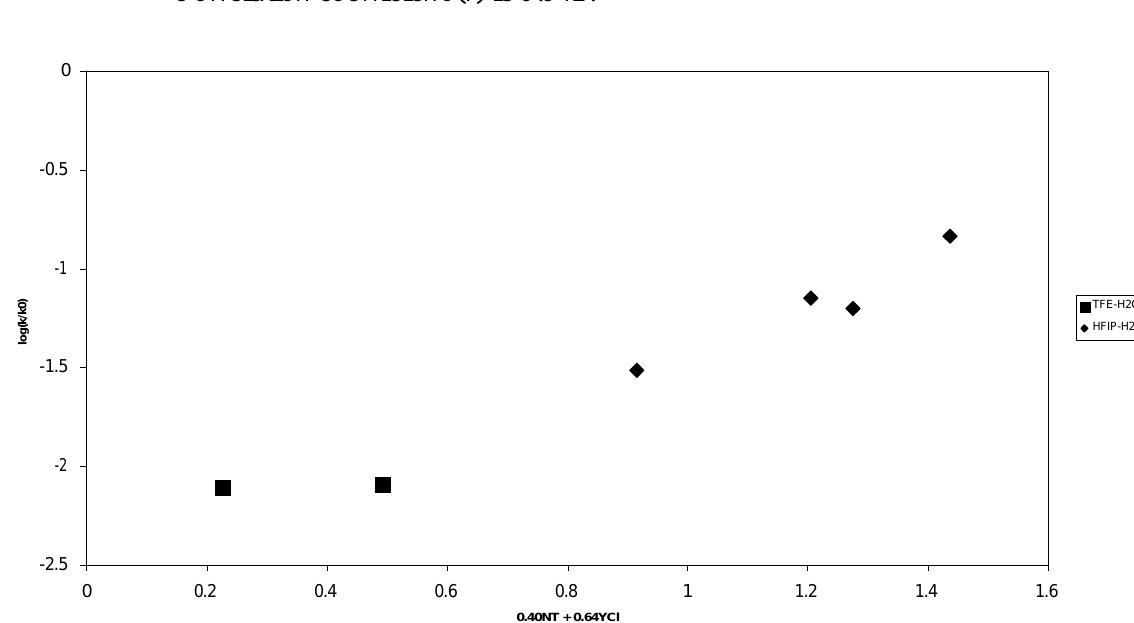
) vs. (0.40 N + 0.64 Y ) for the solvolysis of n -propyl Figure 2. The plot of log ( k / k 0 T Cl chloroformate in TFE, 97% TFE, and aqueous HFIP solvents at 25.0 ºC. Correlation coefficient (r) is